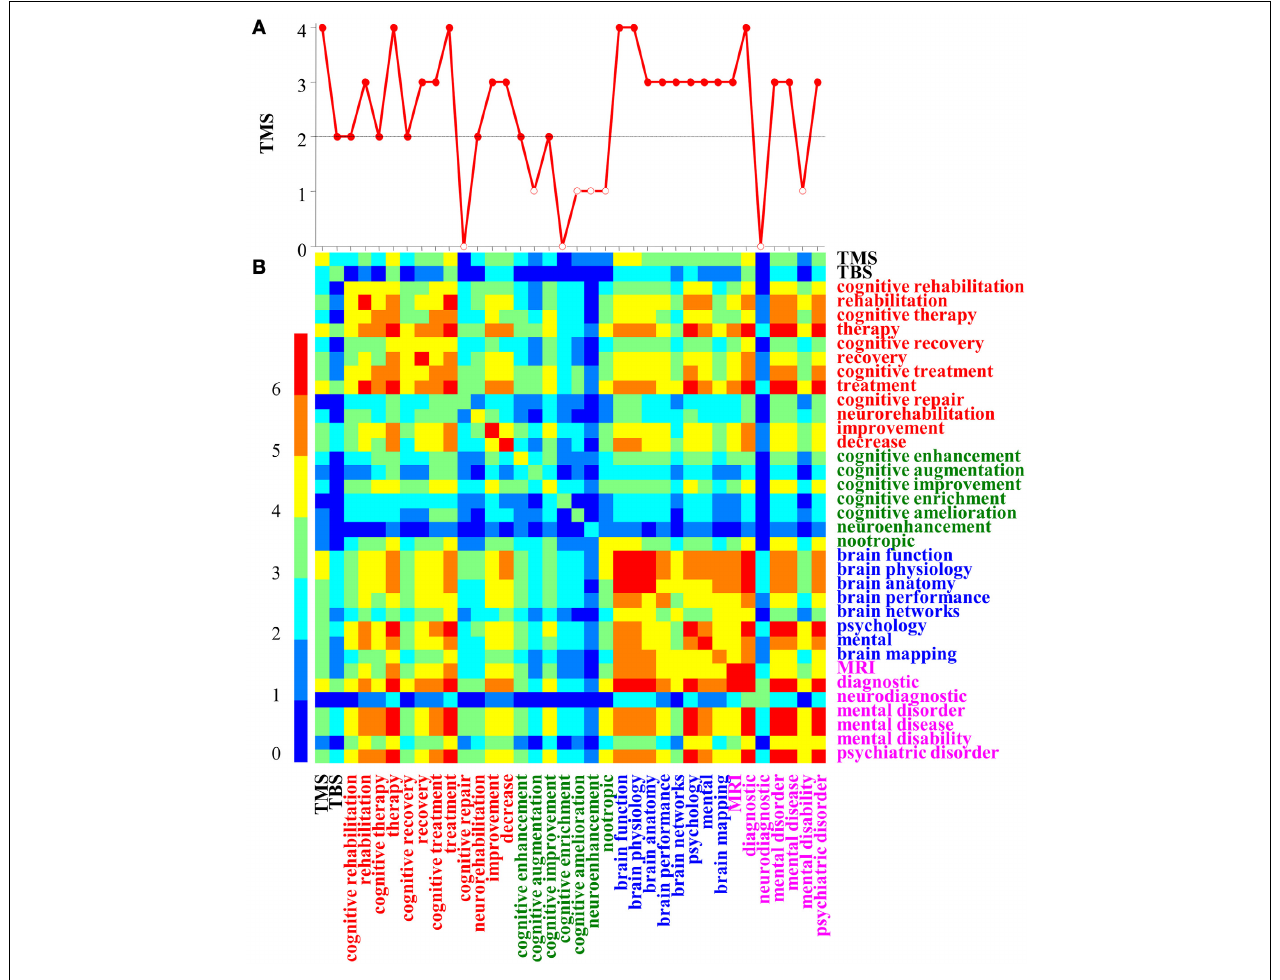
FIGURE 3 | Co-occurrence matrix built with PubMatrix. The matrix (B) represents the decimal logarithm of the number of publications retrieved from PubMed using queries combining all possible conjunctions of pairs of terms (e.g., TMS and neurorehabilitation), which label the lines and the rows of the matrix. Panel (A)